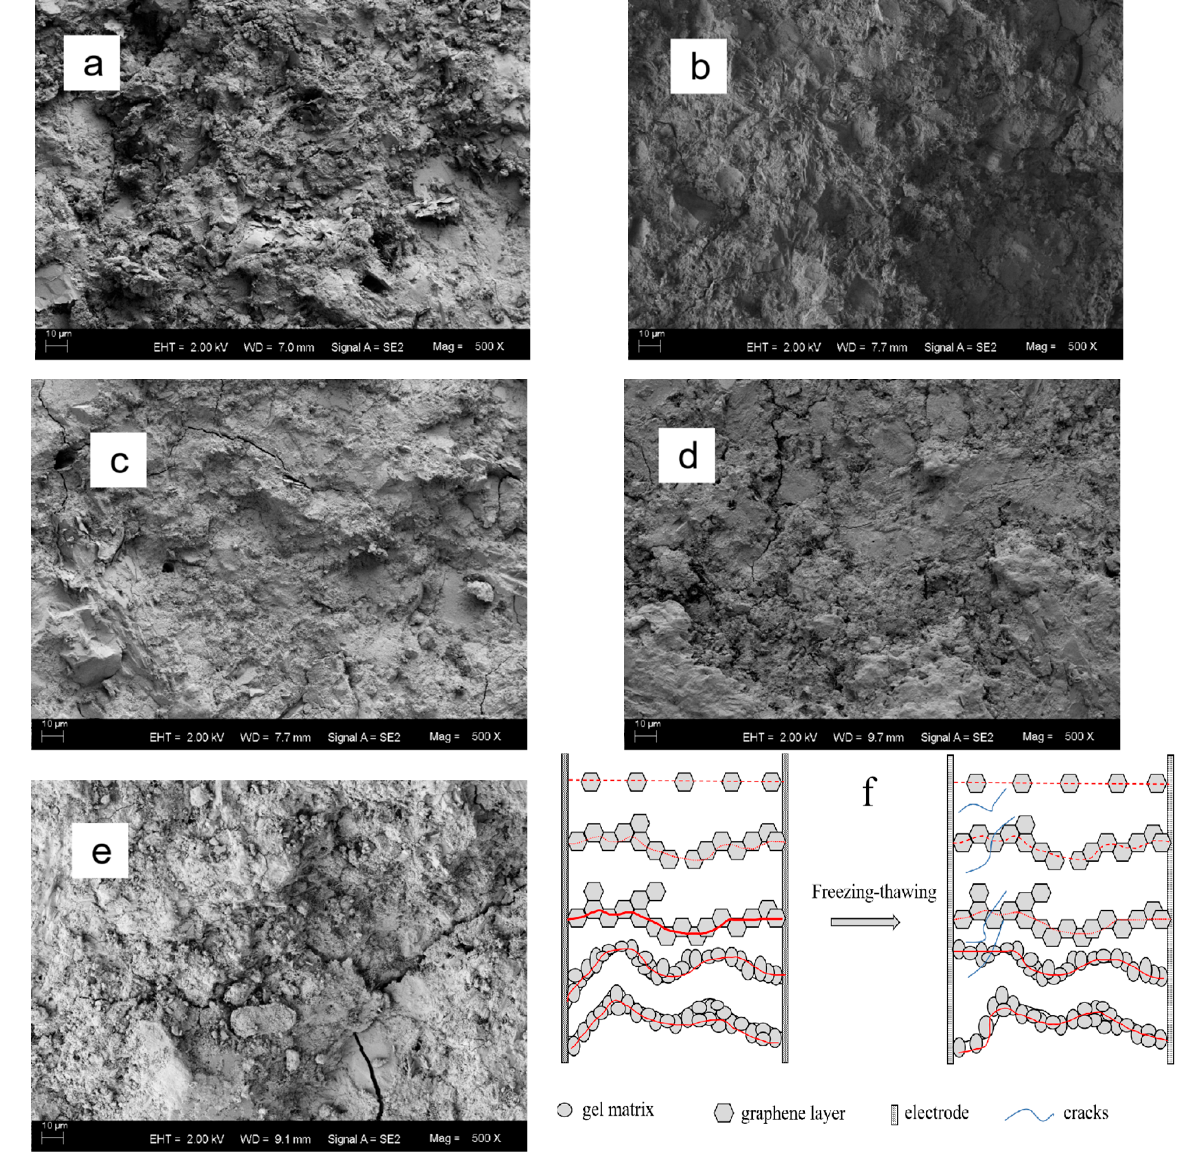
Figure 7. SEM images of graphene-based cement composites and schematic plot of conductive path after different freezing and thawing times: ( a ) 0; ( b ) 25; ( c ) 50; ( d ) 75; ( e ) 100; ( f ) schematic plot.